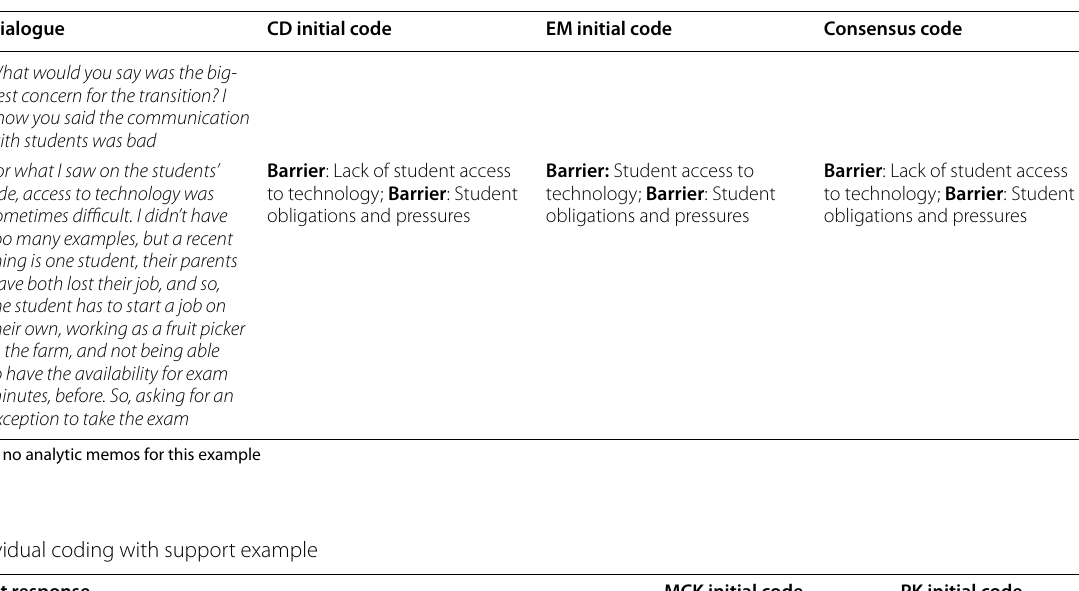
Table 6 Second (axial) cycle consensus coding with barrier example